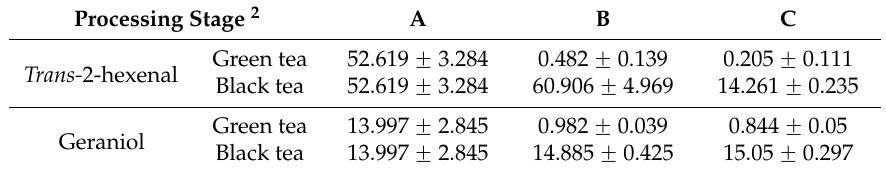
Table 2. Effect of processing on the concentration of partial volatiles in black tea and green tea 1